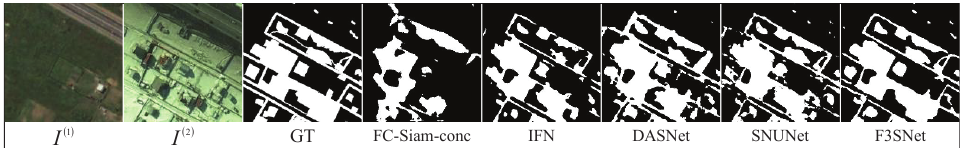
Figure 1. Visualization results of the different methods on the CDD [39] test set. I ( 1 ) and I ( 2 ) are the bi-temporal images, GT is ground truth. FC-Siam-conc [25], IFN [26], DASNet [33] and SNUNet [30] are four different change detection models. F3SNet is our proposed